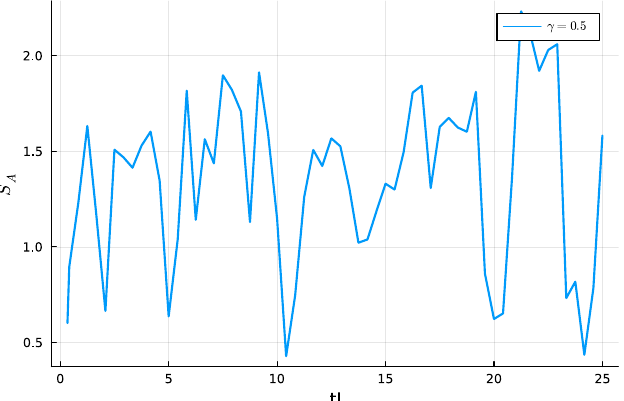
Figure 6: The entanglement entropy computed on the single realization of a quantum = 6, and the number of bosons trajectory. Here, U = J and the number of sites N s = 3, and subsystem size L = 3. The measurement rate is γ/ J = 0.5. N b A